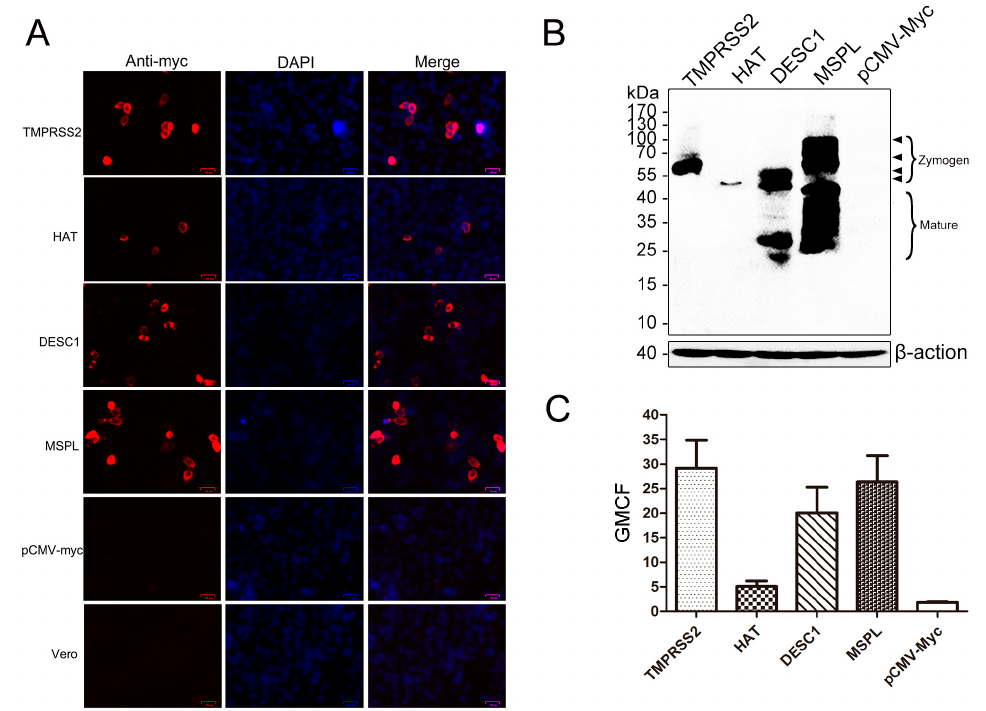
Figure 1. Expression of type II transmembrane serine proteases (TTSPs) in transfected Vero cells. ( A ) Post-transfection, the expression of TMPRSS2, HAT, DESC1, and MSPL in transfected Vero cells was detected via indirect immunofluorescence. Bar = 25 μ m. Magnification, ×200; ( B ) TTSP expression in transfected Vero cells as determined by western blot. Zymogens and the mature form are indicated; ( C ) TTSPs expression was detected by FACS. The geometric mean channel fluorescence (GMCF) measured in a representative experiment performed with triplicate samples is shown. Error bars indicate standard deviations of three independent experiments.